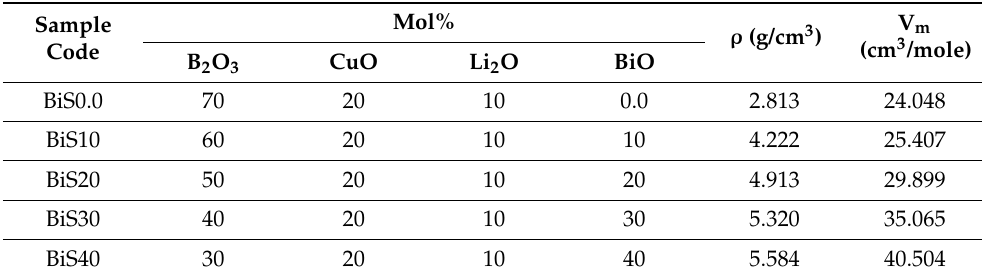
Table 1. Chemical compositions, density, and molar volume of present glass